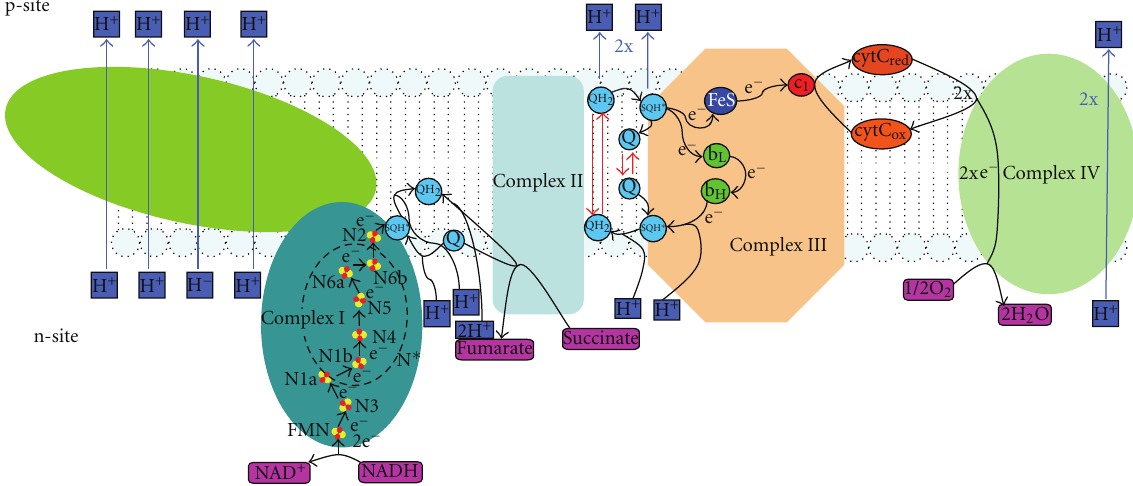
Figure 2: Schematic of the respiratory chain. The respiratory chain: in complex I, NADH is oxidized to NAD, while four protons are pumped from the mitochondrial matrix into the intermembrane space/cytosol. Concomitantly ubiquinon (Q), residing in the inner membranous space, is reduced to ubiquinol (QH 2 ) along with the uptake of two matrix protons. In Complex II, succinate is oxidized to fumarate while ubiquinon is reduced to ubiquinol. In this reduction two protons are taken up from the matrix space, but no protons are pumped across the mitochondrial membrane. In complex III, innermembranous ubiquinol is oxidized to ubiquinon. Via the q-cycle mechanism, two protons are taken up from the matrix space, and four protons are released into the inter membrane space/cytosol. The two electrons are consecutively transferred via Fe-S cluster to cytochrome c1 and reduce two molecules of cytochrome c. In complex IV, two molecules of reduced cytochrome c are oxidized, and oxygen is reduced to water along with the transduction of two protons from the matrix space into the inter membrane space/cytosol. With either NADH or succinate as substrates, the respiratory chain pumps ten and six protons, respectively, from the matrix space to the inter membrane space/cytosol, and one molecule of water is formed.